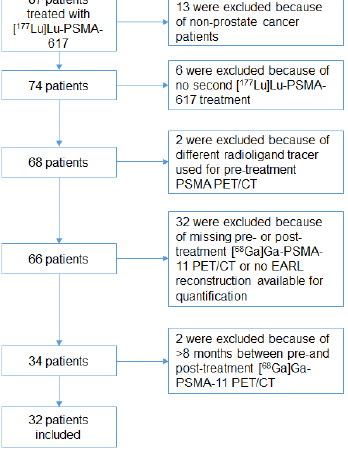
Figure 1. Flow ‐ chart of the retrospective included patients. Figure 1. Flow-chart of the retrospective included